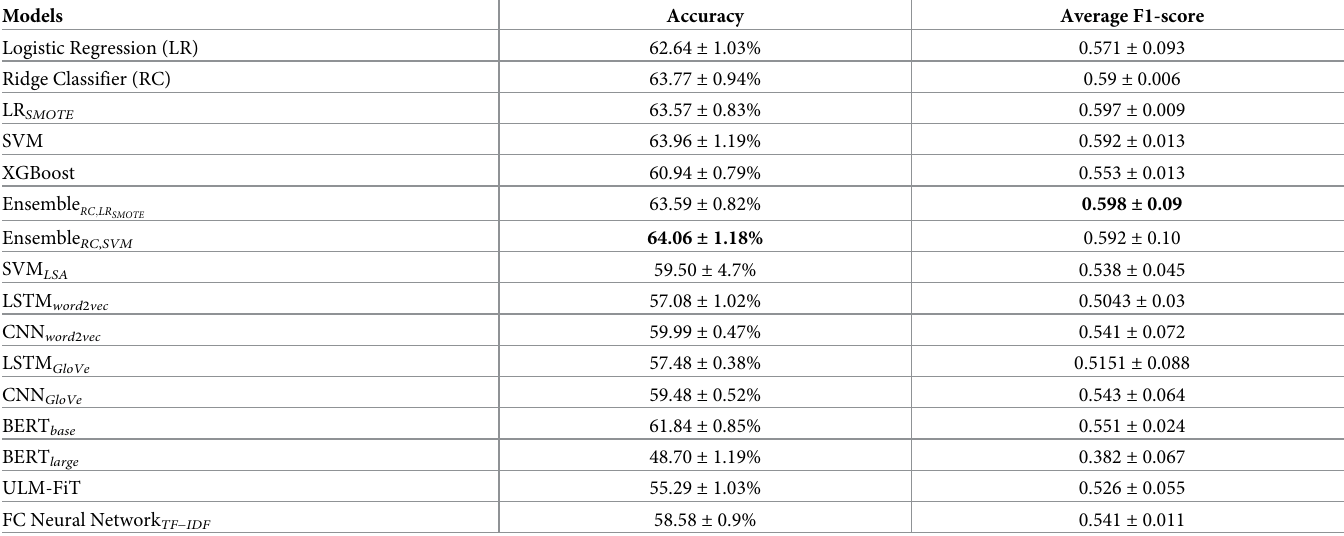
Table 4. Classification results with all